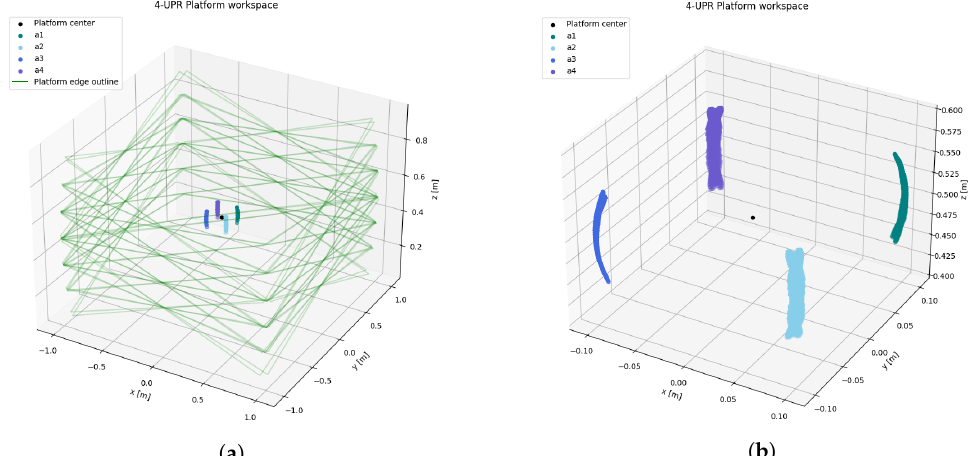
Figure 6. Workspace analysis of a 4-UPR platform for z = 0.5 m: ( a ) Workspace with platform outline; ( b ) Workspace without platform outline.